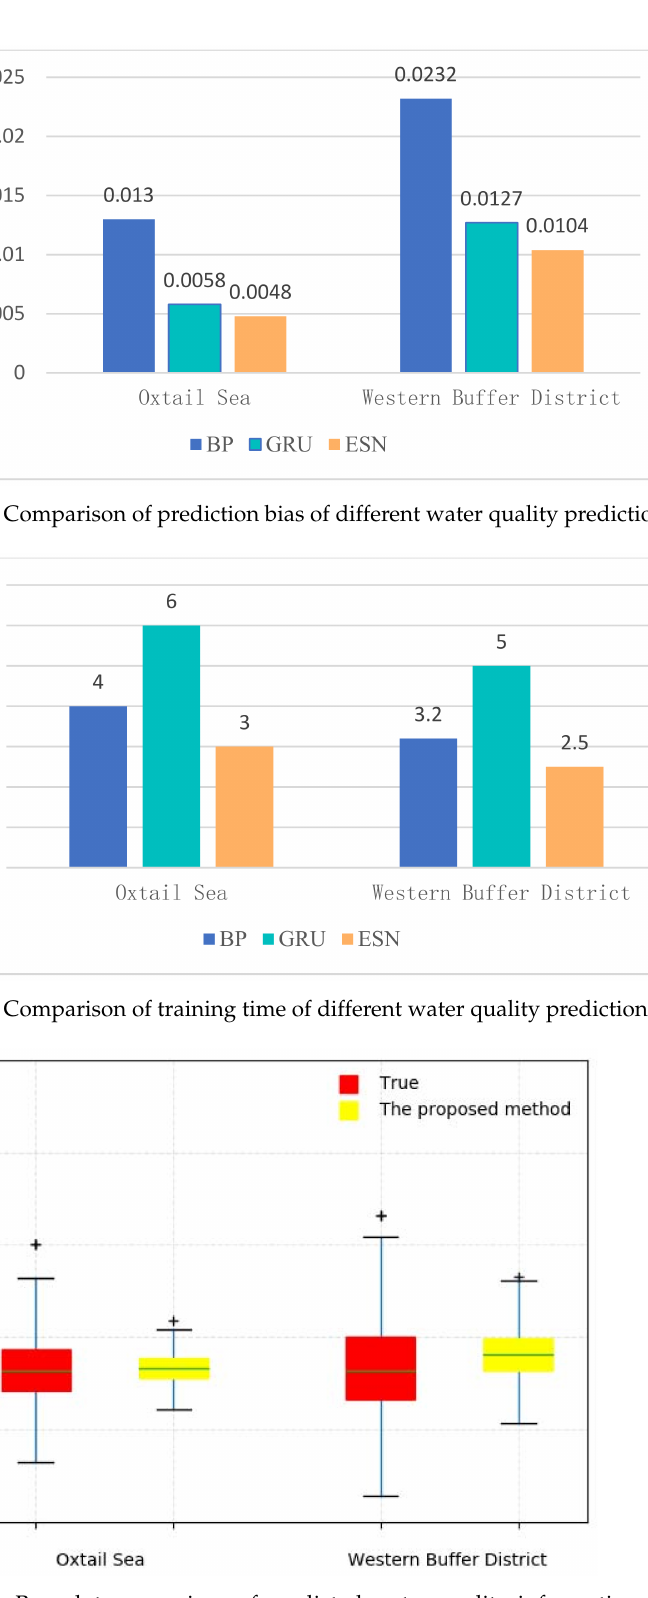
Figure 12. Box-plot comparison of predicted water quality information and real water quality